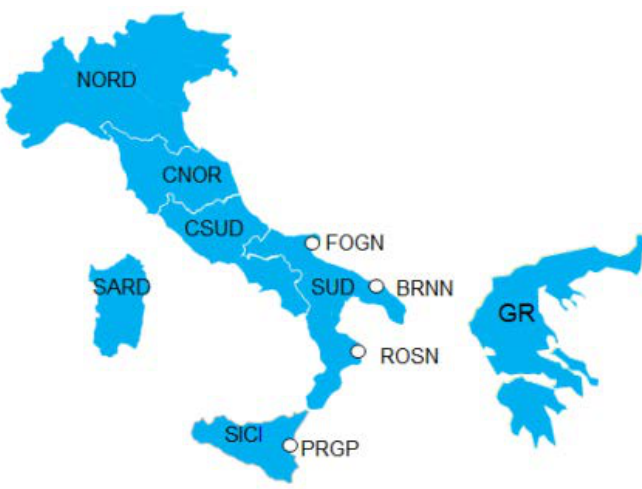
Figure 9. Italian load subdivision zones for the Italian Power Exchange (IPEX).